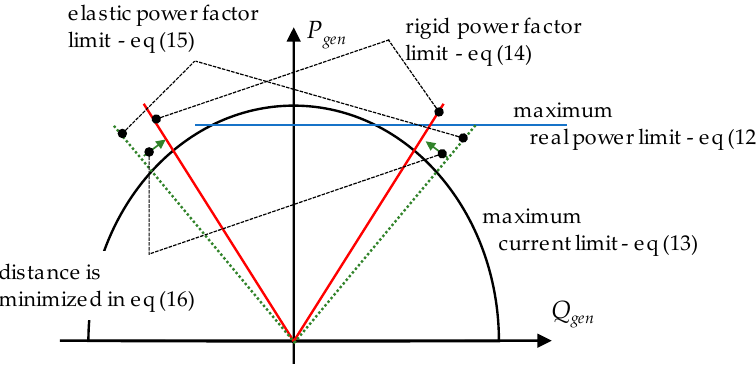
Figure 7. Modeled capability curved for a RES generator.